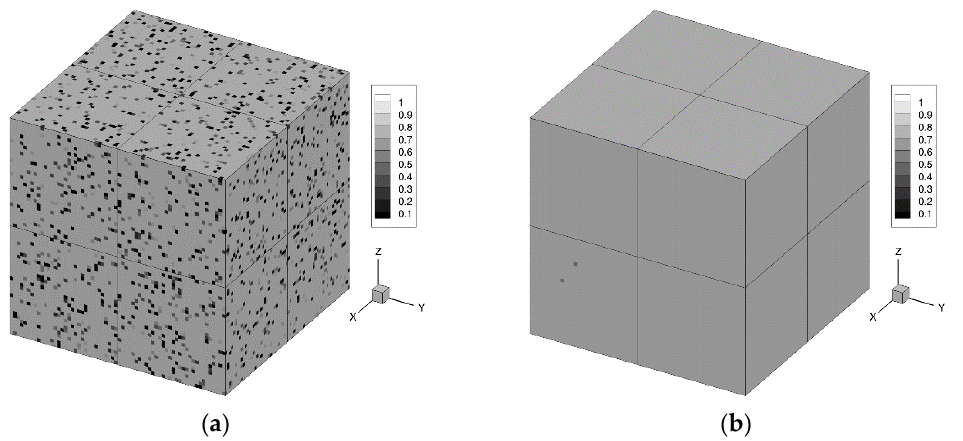
Figure 1. The field of the weight, F KH ( VTM ) , on mesh with 64 3 cells. ( a ) Without VTM averaging; ( b ) with VTM averaging.